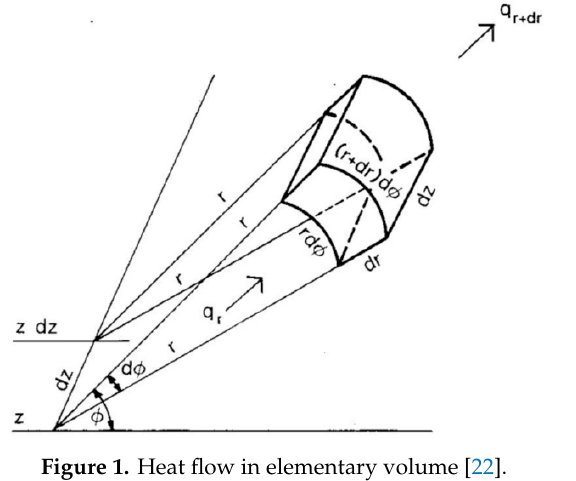
Figure 1. Heat flow in elementary volume [23].